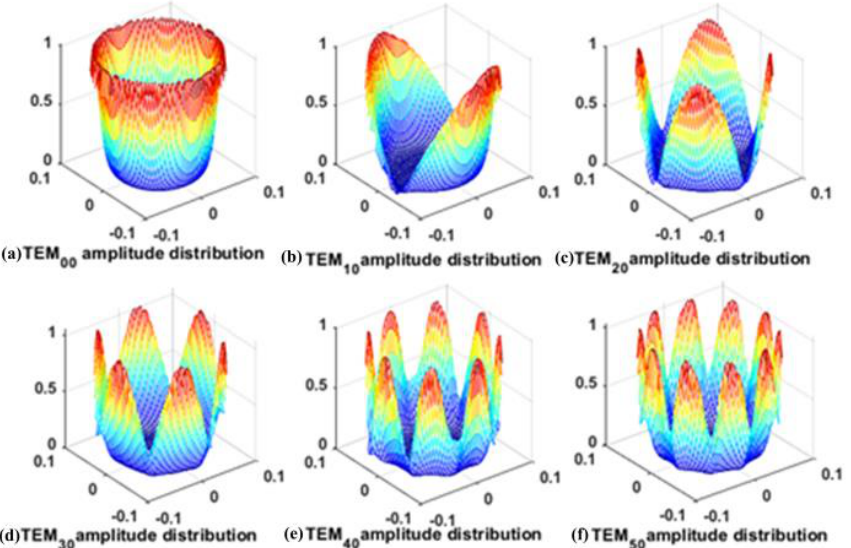
Figure 6. Amplitude distribution of the different modes. ( a ) TEM 00 amplitude distribution; ( b ) TEM 10 amplitude distribution; ( c ) TEM 20 amplitude distribution; ( d ) TEM 30 amplitude dis-